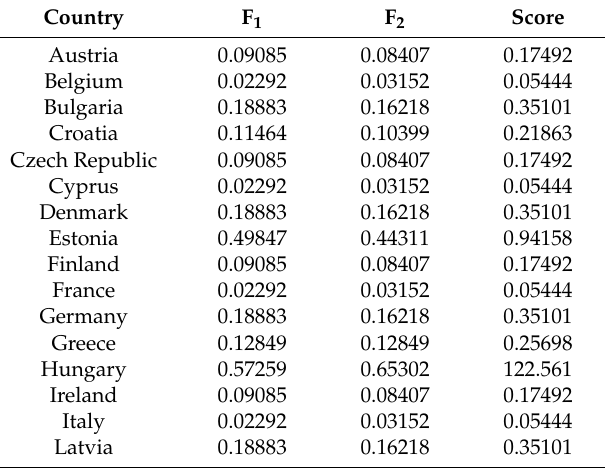
Table 4. The results obtained by performing Step